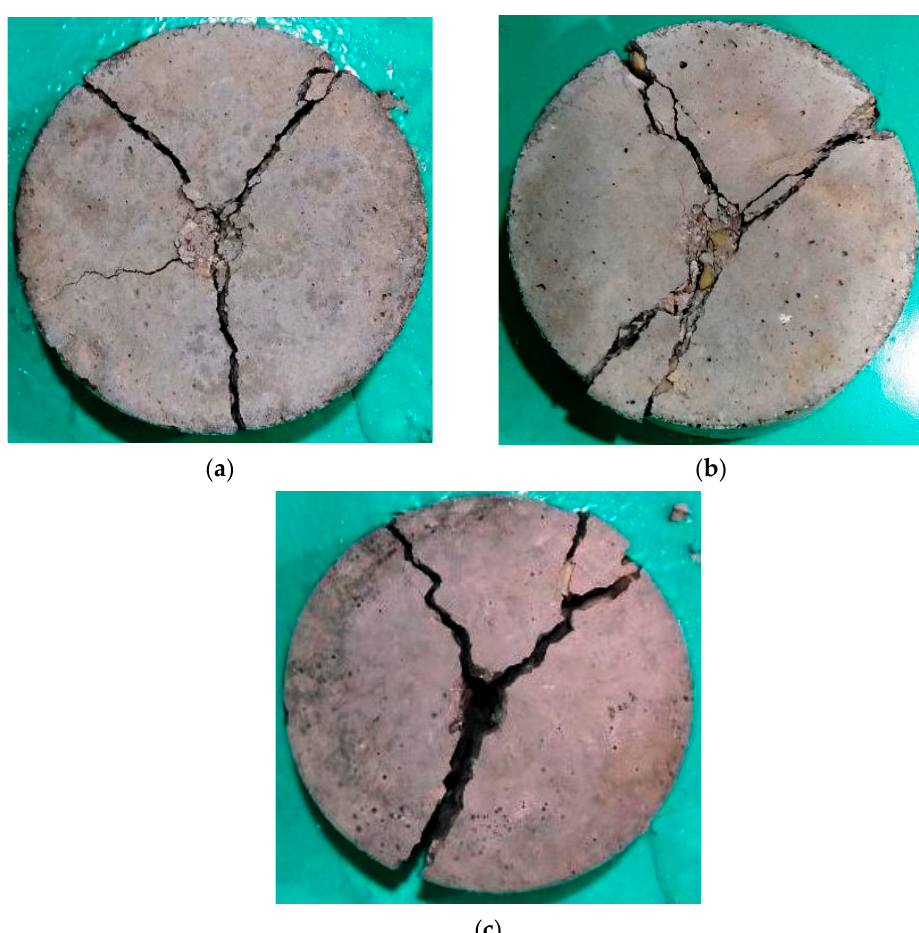
Figure 15. Failure patterns of cylindrical specimens heated to 200 °C: ( a ) M20, ( b ) M40, ( c ) M80.